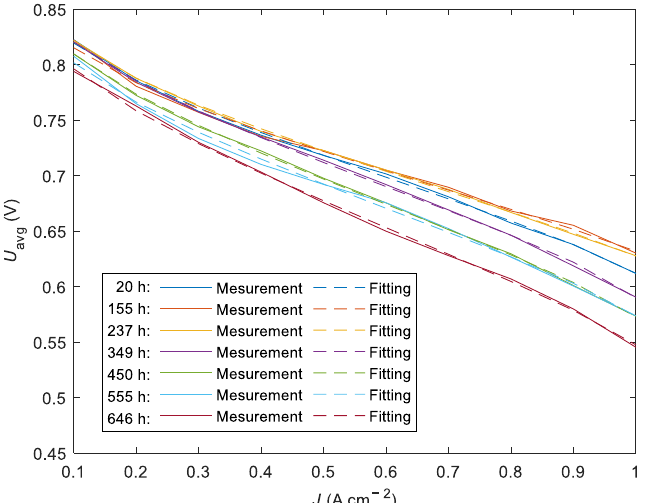
Figure 3. Polarization curves during the aging test.